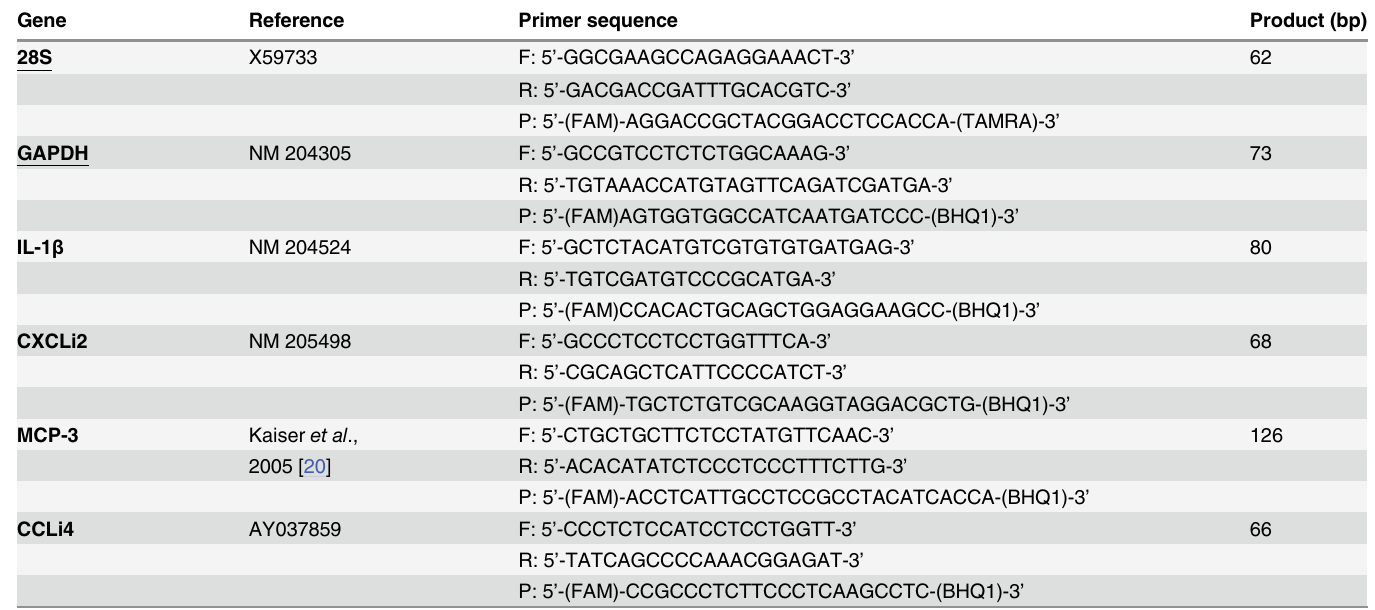
Table 2. Primers used for quantitative real time PCR.